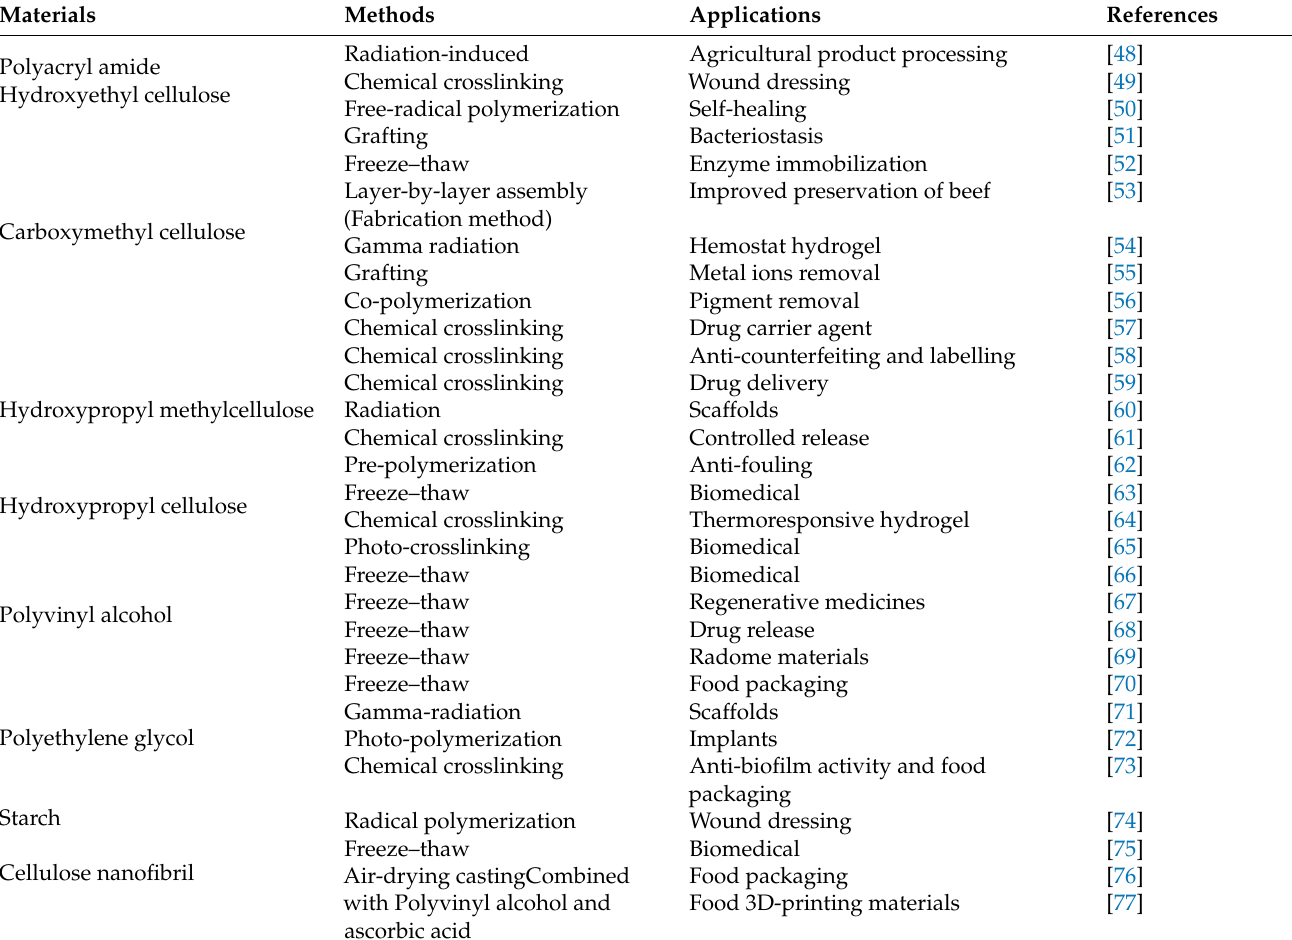
Table 1. Materials, methods, and applications employed in the preparation of